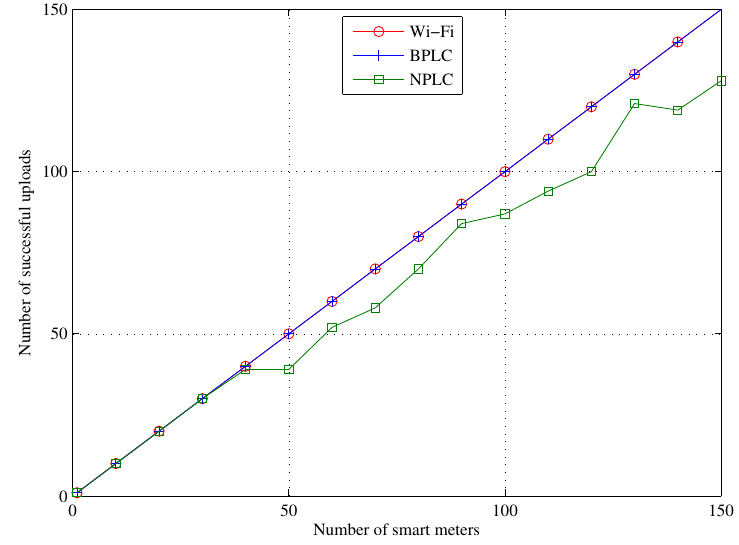
Figure 3. Variation of meter reading upload with cluster